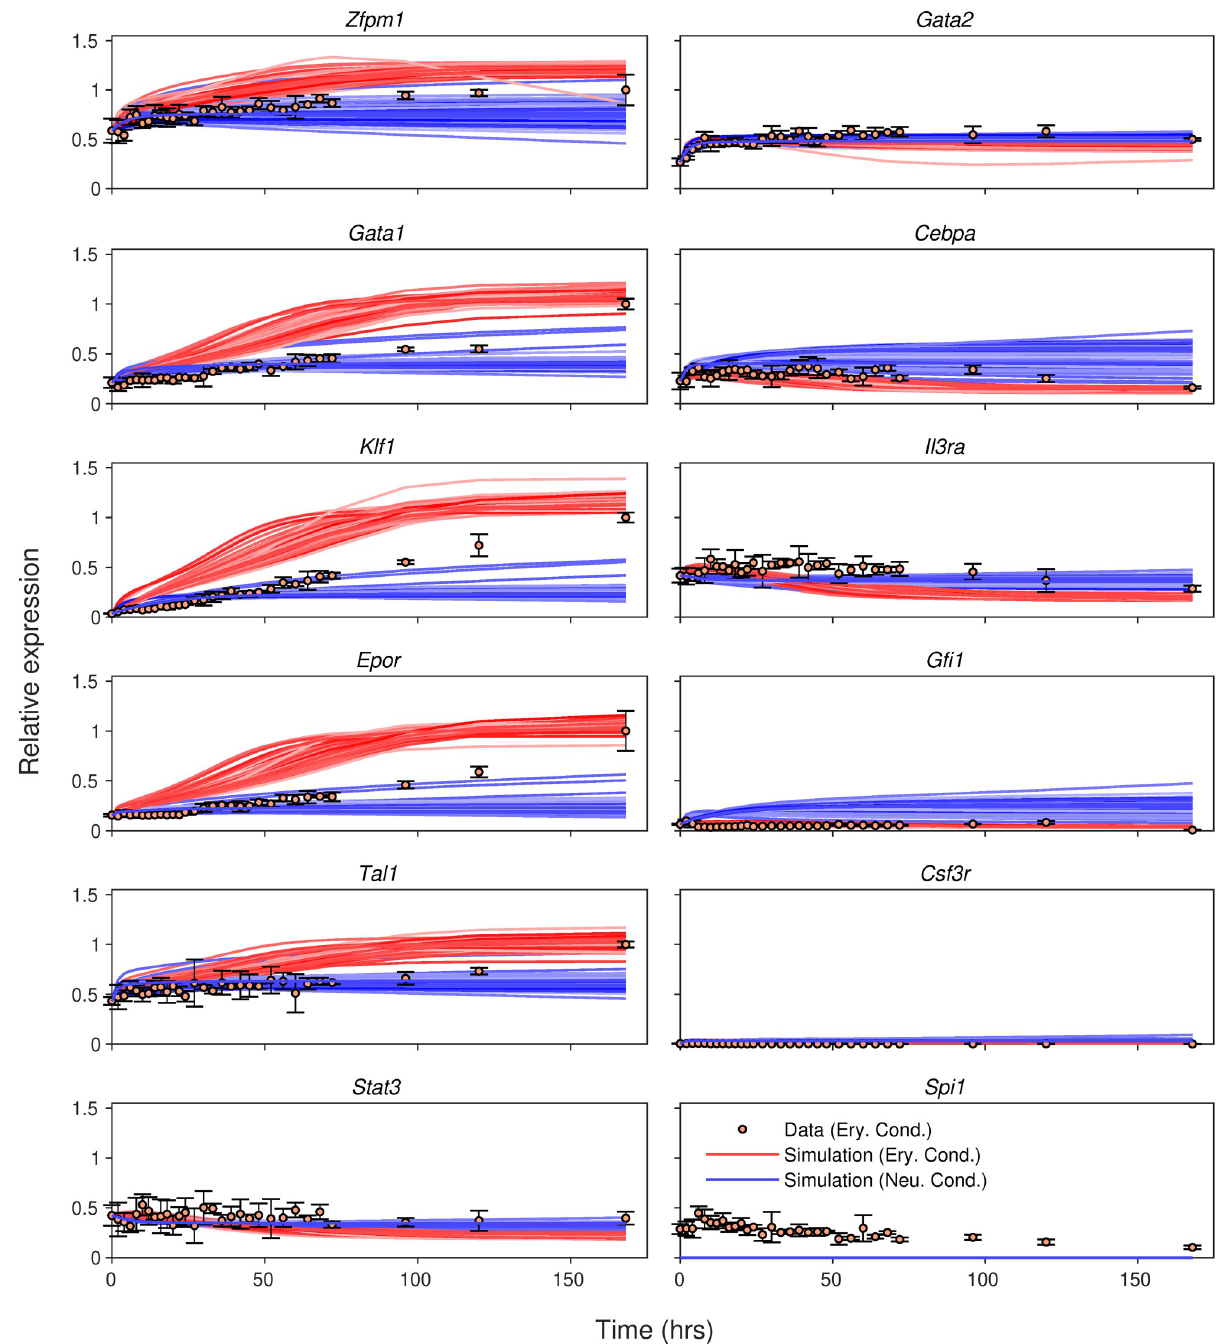
Fig 2. Simulation of Spi1 knockout. Spi1 knockout was simulated in all 71 models that met the goodness-of-fit criteria. Their output is plotted as lines. The symbols and colors are the same as Fig 1.